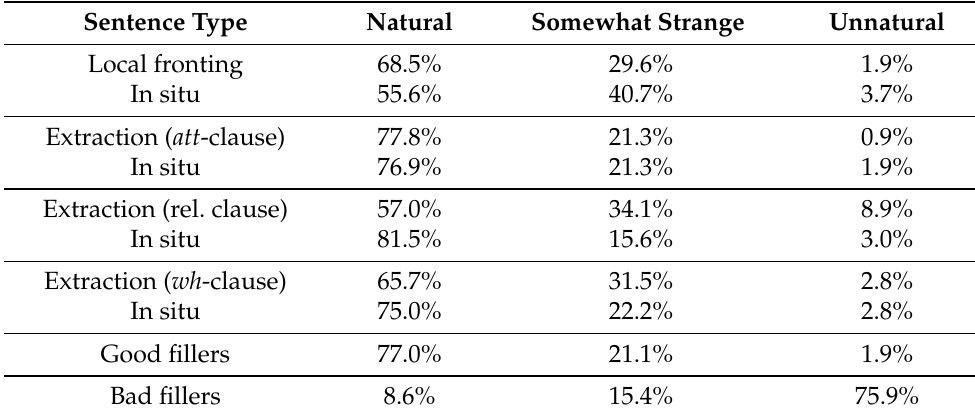
Table 1. Answers per sentence type,